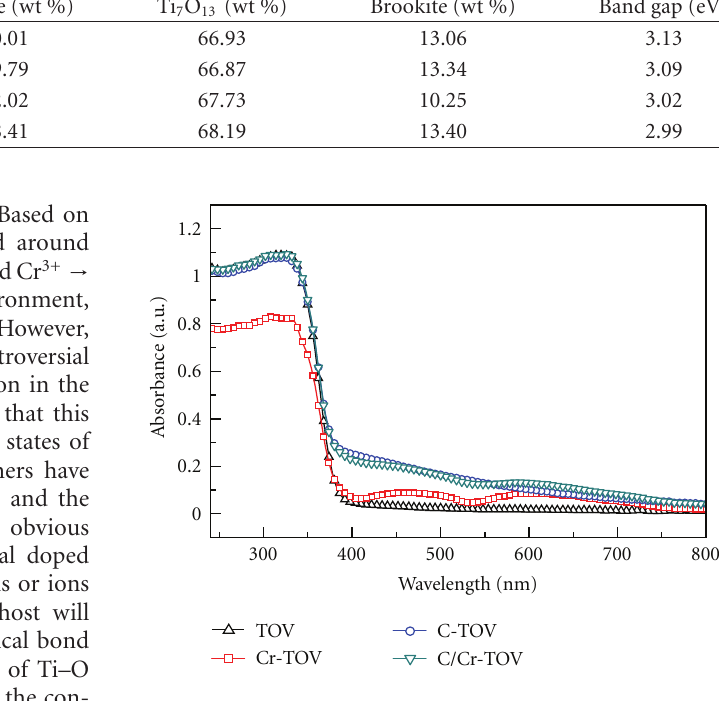
Figure 2: UV-vis absorption spectra of the samples with di ff erent oxygen